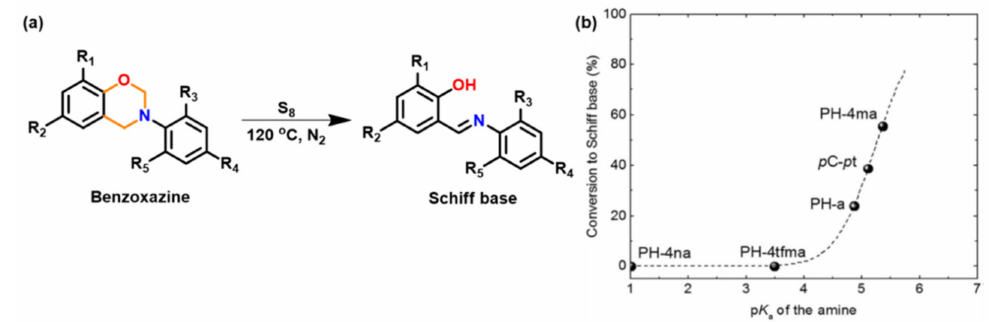
Figure 43. ( a ) Generation of Schiff base from the reaction between benzoxazine resins and S 8 and ( b ) conversion of Bz monomer to Schiff base as a function of the pK a of the amine in benzoxazine [286]. Copyright 2016. Reproduced with permission from Royal Society of